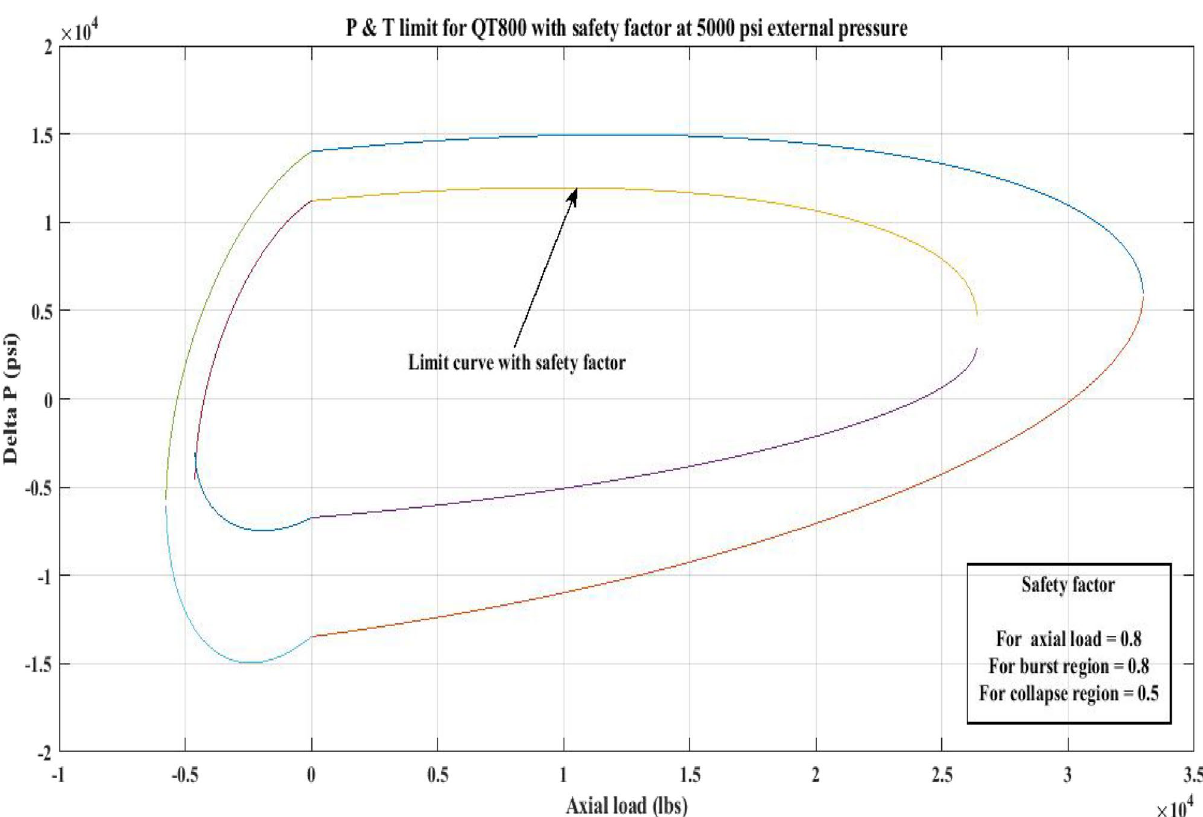
Figure 18. P and T limit with safety factor for QT800 at 5000 psi P o .